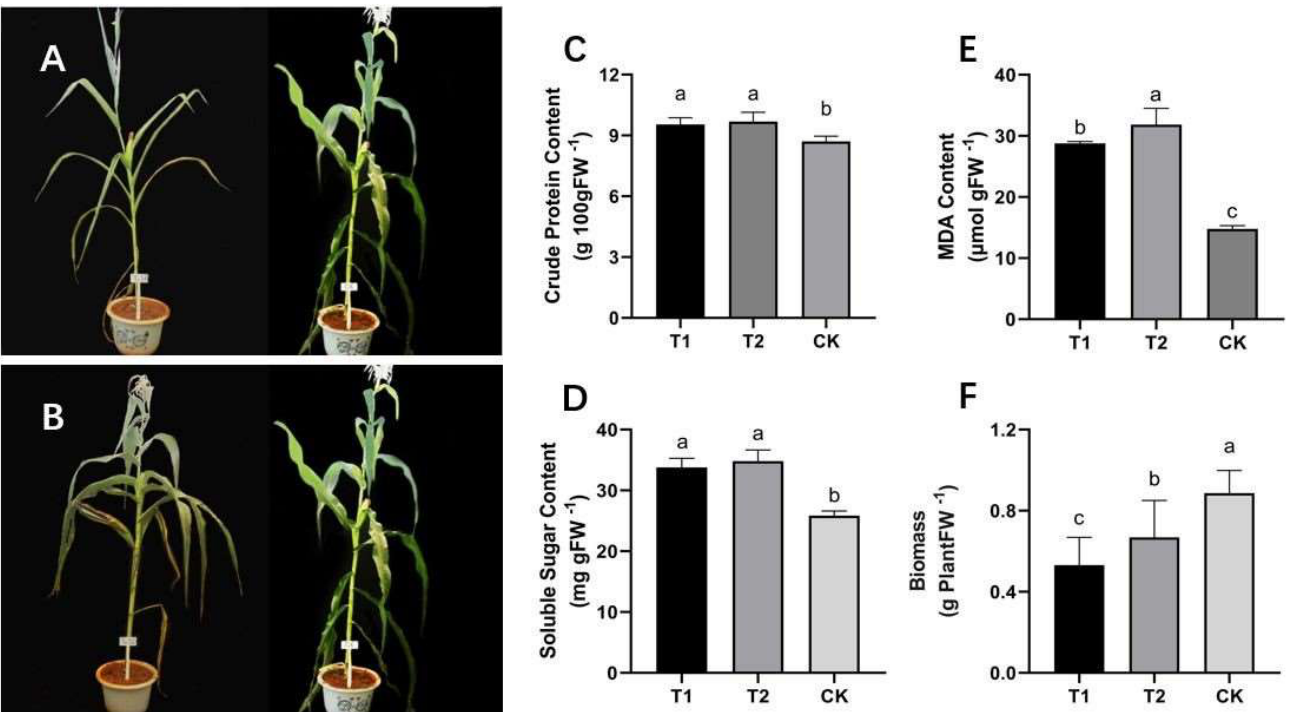
Figure 1. Phenotypic and physiological changes of control maize plants and those exposed to T1 and T2 water stress treatments. T1 and T2 represent long-term severe drought stress during the seedling and flowering stages, respectively, and CK is the conventional irrigated control. ( A ) phenotypes of drought treatment T1 and control CK in the seedling stage at harvest; ( B ) phenotypes of drought treatment T2 and control CK in the flowering stage at harvest; ( C ) changes in total protein content of the whole maize plants in each treatment; ( D ) changes in the soluble sugar content of treated maize leaves; ( E ) changes in the accumulation of malondialdehyde (MDA) in the maize leaves in each treatment; ( F ) comparison of the biomass of the whole maize plants at harvest. Different lowercase means values significantly different at p < 0.05. Each treatment has three replicates.